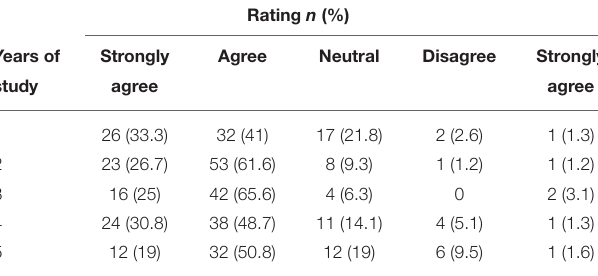
19) [ Figure 1 : Mean and SD of the Attitudes Toward Psychiatry (ATP-30)